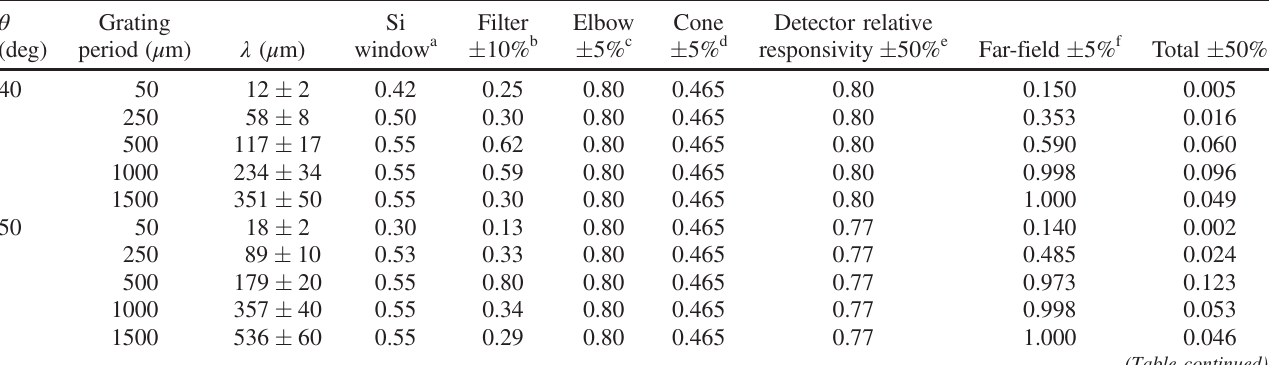
TABLE I. Transmission factors for each element of the optical system and their uncertainties. The tabulation is presented as a function of the observation angle θ and the corresponding wavelength, for each grating used in these experiments.